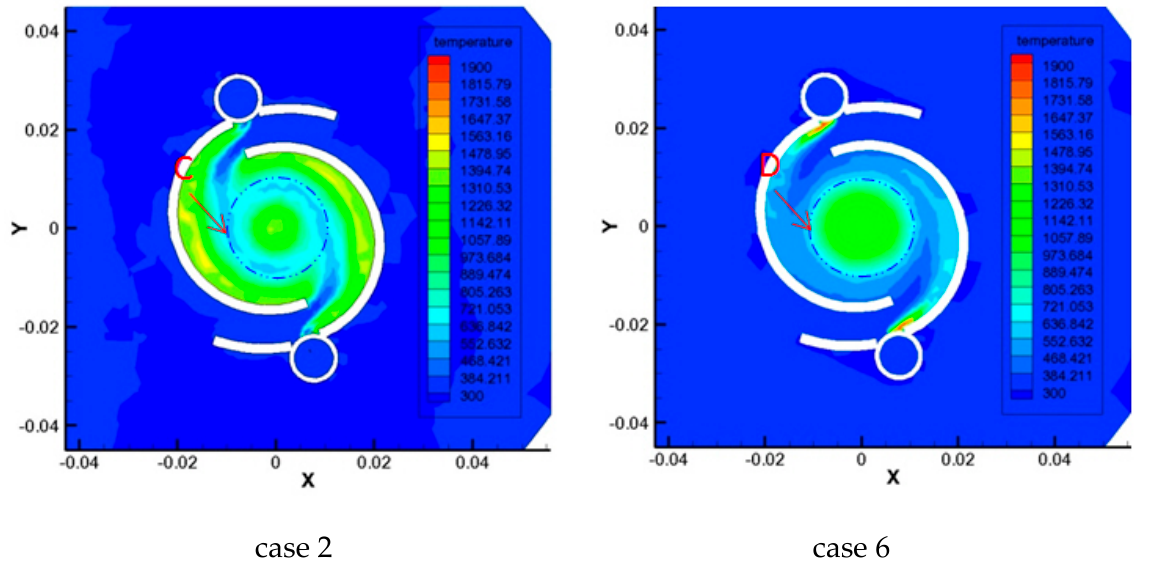
Figure 9. Sectional distribution map of temperature distribution at Z = − 50mm.